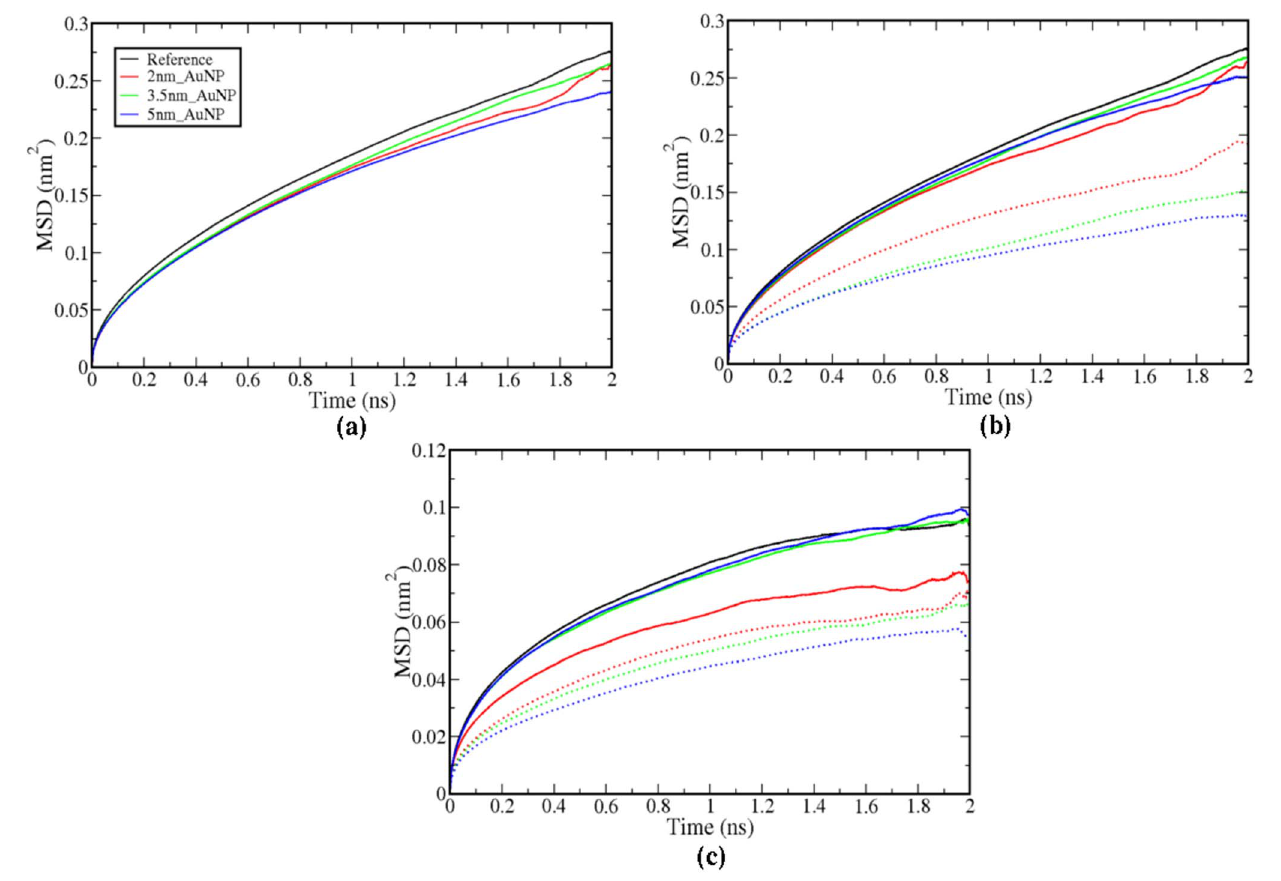
Figure 8. (a) Lateral MSD of all AOPC lipid in the system, (b) lateral MSD of (only interacting leaflet) and (c) MSD of interacting leaflet along bilayer normal. Dotted lines represent MSDs of SR lipids whereas solid lines are for LR lipid molecules.